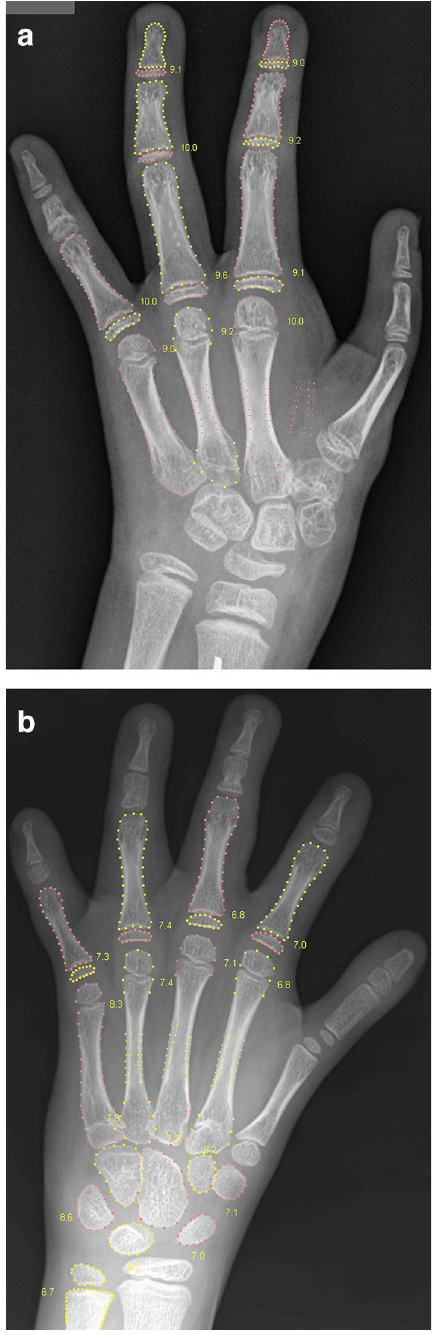
Figure 7. Two females, 4210 and 13,824, from the RSNA study with 10 and 9 accepted tubular bones. Ray 2 is missing in the first image, which causes the Bone Health Index analysis to fail (indicated by the code 3). The radial epiphysis is abnormally thickened and there is pronounced positive ulnar variance. The first digit is likely to be a pollicised index finger following surgery for thumb aplasia or severe hypoplasia; a likely case of radial longitudinal reduction defect. The second image shows brachydactyly in the middle phalanges. Finger 1 has two epiphyses in the metacarpal, and either a thick epiphysis in the distal phalanx or an extra short phalanx; the thumb is somewhat ‘finger-like’. The second and fifth digits similarly appear biphalangeal with large epiphyses of the distal phalanges. Digits 3 and 4 show middle phalangeal hypoplasia. Appearances suggest an underlying genetic disorder of hand-development requiring further